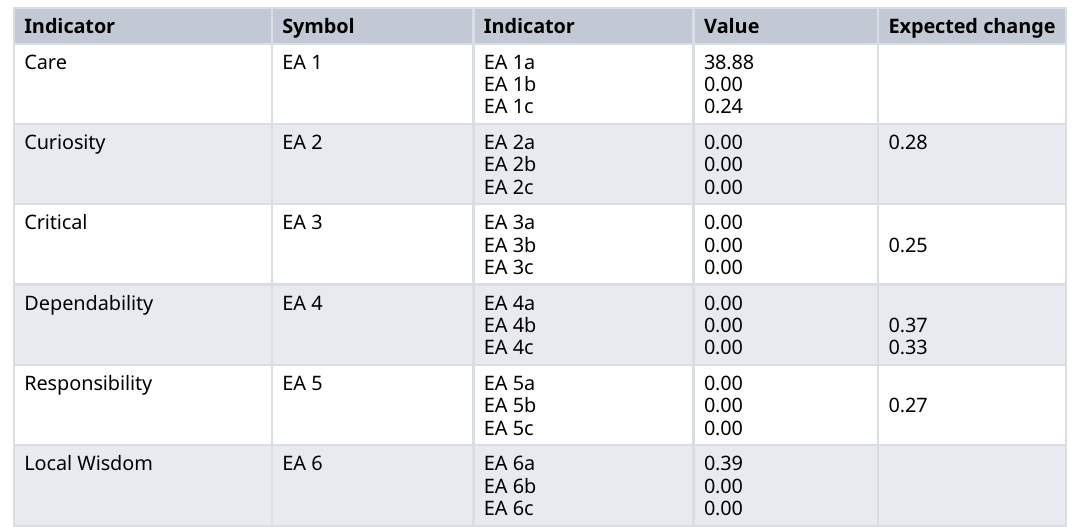
Table 4. Expected change second-order confirmatory factor analysis results.